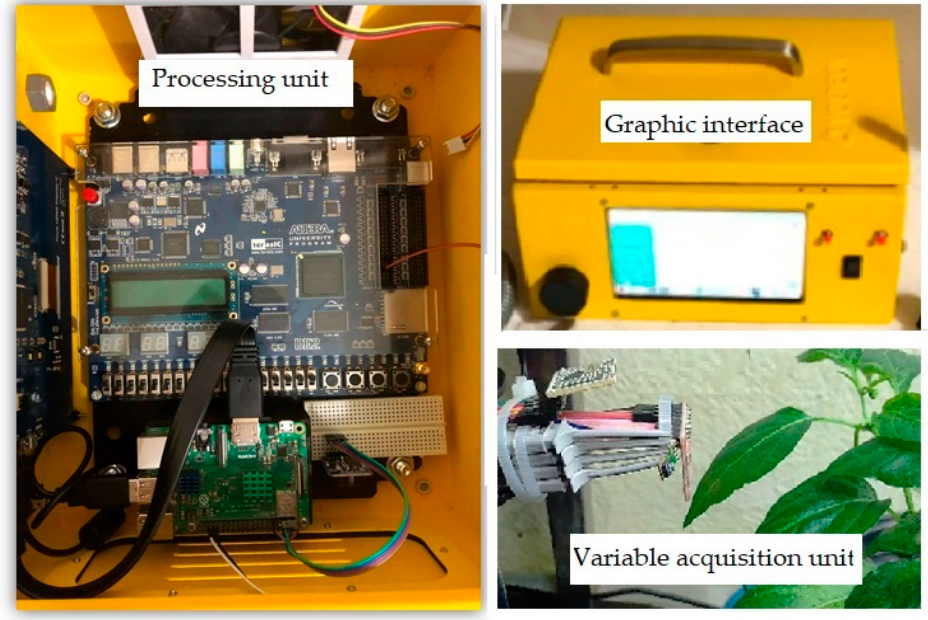
Figure 8. Net photosynthesis estimation equipment based on non-invasive techniques.